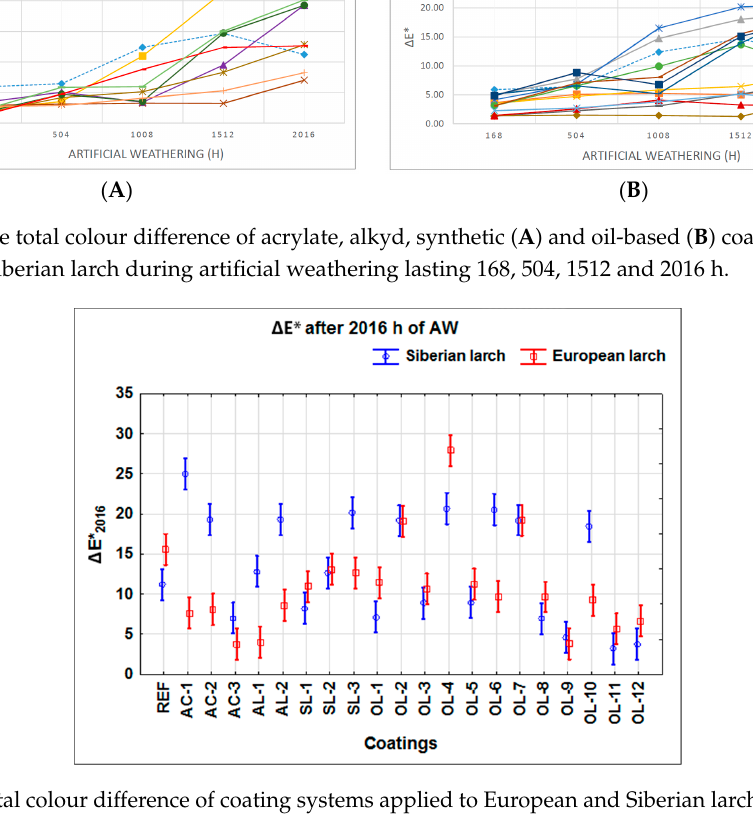
Figure 5. Total colour difference of coating systems applied to European and Siberian larch after 2016 h of artificial weathering evaluated as 95% two-side confidence intervals. The Tukey HSD test shows that the differences in the analysed values were statistically significant ( p -value < 0.05) for coating systems AC-1, AC-2, AL-1, AL-2, SL-3, OL-4, OL-6 and OL-10.